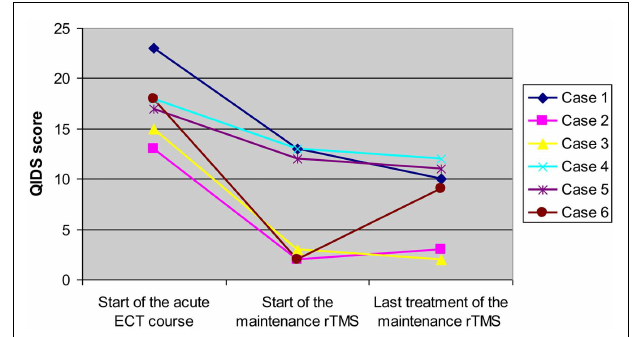
FIGURE 1 | Longitudinal changes in QIDS score of each subject over acute ECT course and maintenance rTMS treatment for refractory depression